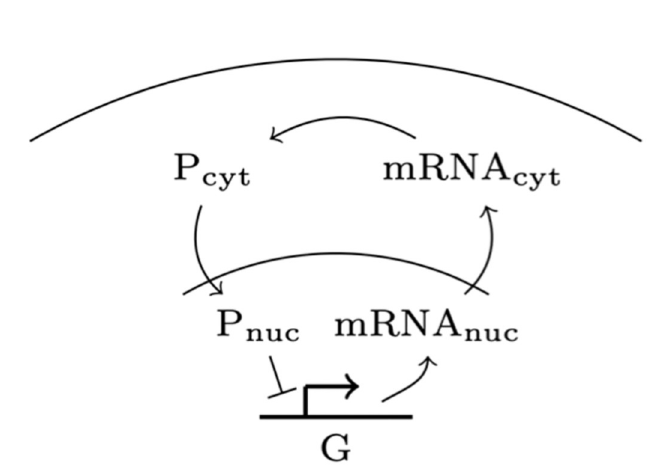
Fig 2. Sketch of the genetic motif studied in this article. A gene, placed at the center of the nucleus of the cell, transcribes mRNA. mRNA then diffuses out of the nucleus and into the cytoplasm, where it is translated to proteins. These proteins then diffuse back into the nucleus, where they repress the expression of the gene.